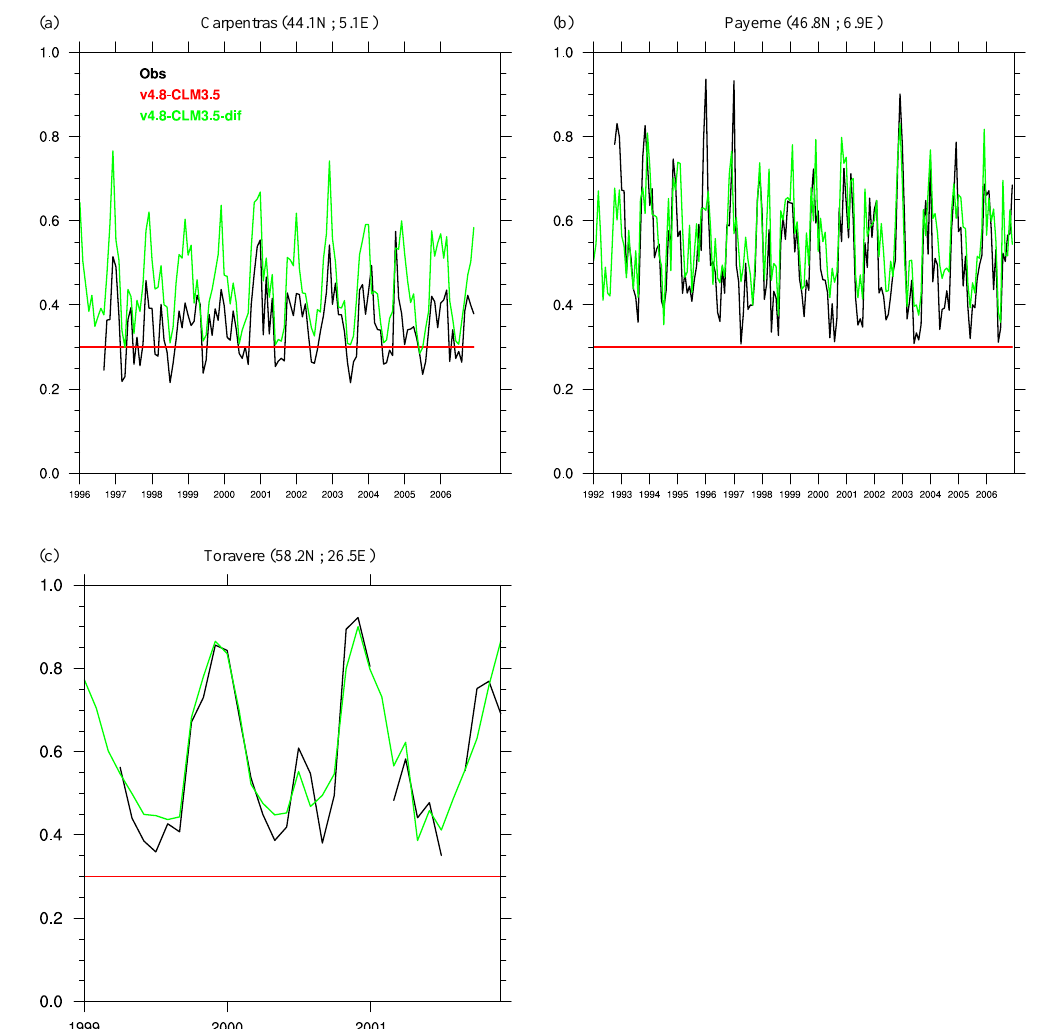
Fig. 5. Time series of diffuse light fraction (monthly means) at three different BSRN sites.